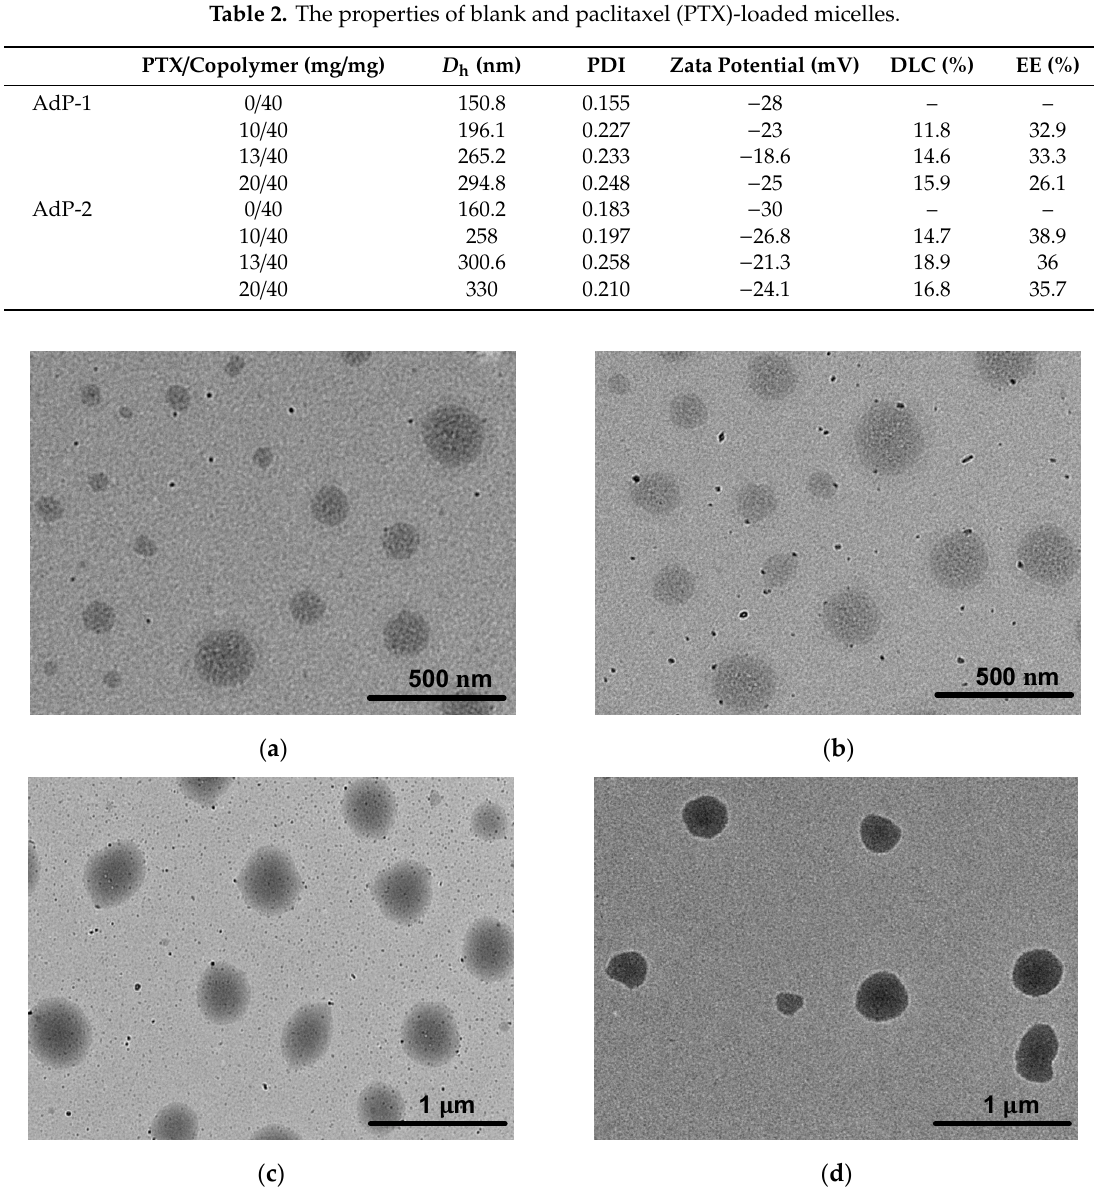
Table 2. The properties of blank and paclitaxel (PTX)-loaded micelles.